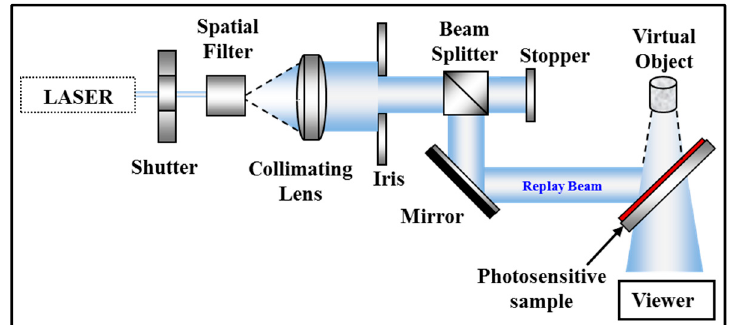
Figure 5 . Basic set-up for reconstruction an off-axis transmission type hologram. Figure 5. Basic set-up for reconstruction an off-axis transmission type hologram.